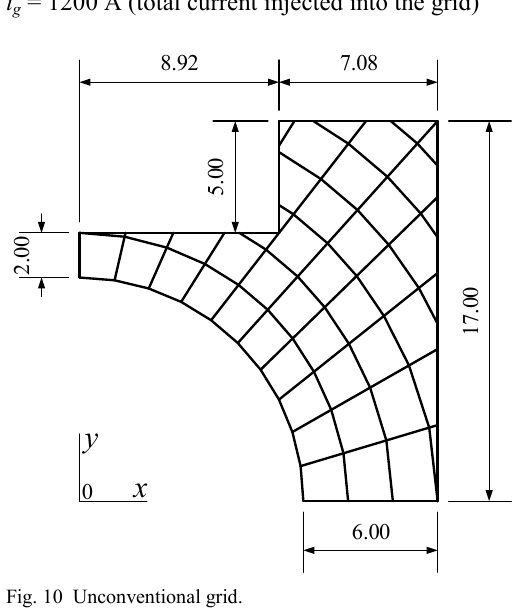
Fig. 10 Unconventional grid.